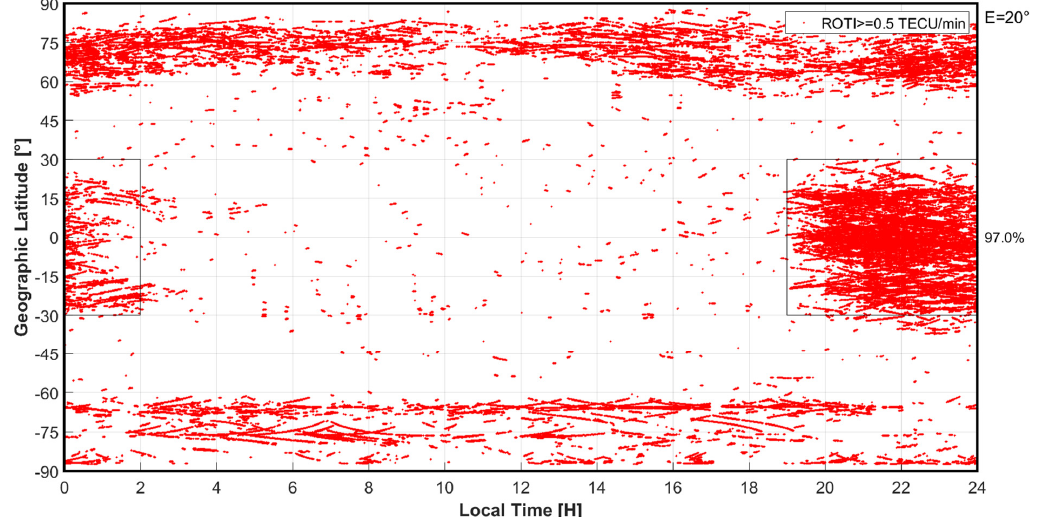
Figure 13. Spatial distribution of global ionospheric irregularities (only ROTI ≥ 0.5 TECU/min are displayed). The total number of ionospheric irregularities detected (163,879) corresponds to approximately 2.0% of the total number of observations obtained on this day. The regions most likely to be affected by ionospheric disturbances are South America and the Arctic.